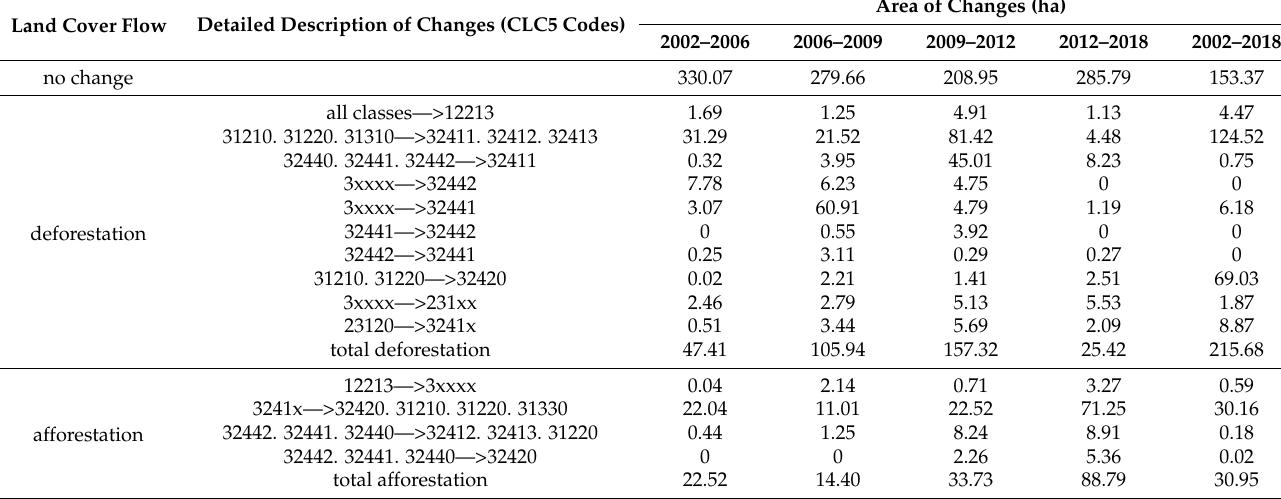
Table 8. Detailed development of land cover-changes in surroundings of ˇCertovica